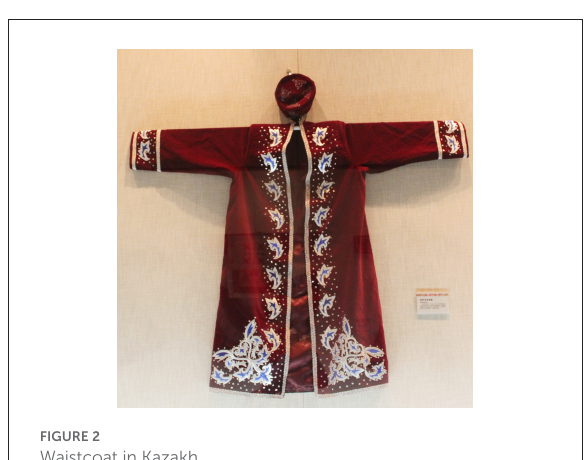
FIGURE2 Waistcoat in